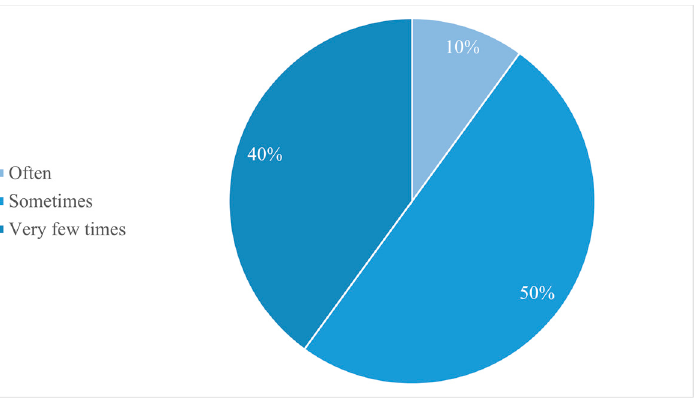
Figure 20. Answers to the question “Were the application graphics ever distracting you from performing specific tasks?”.